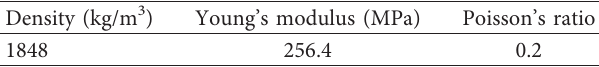
Figure 9: Stress-strain behaviour of caved material in gob. Table 5: Parameters used in the elastic model for caved